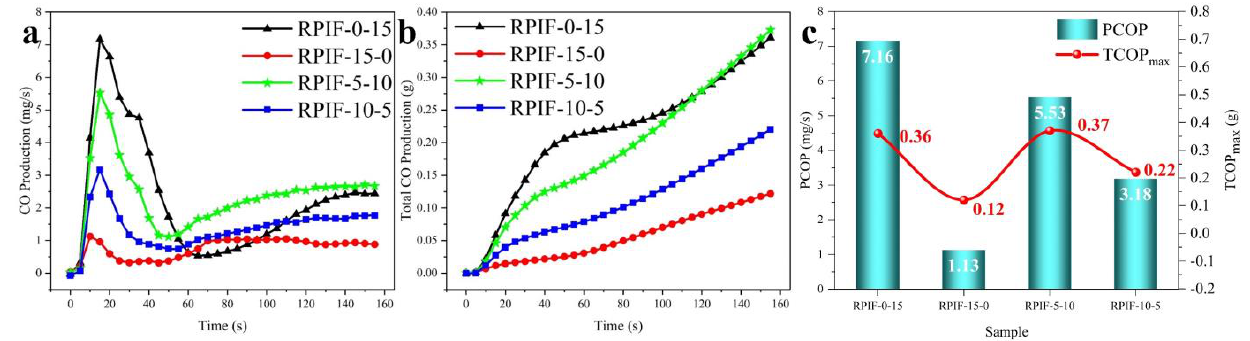
Figure 11. COP ( a ) TCOP ( b ) curves, PCOP and TCOP max ( c ) of RPIF with total dosages of EG and PPCP at 15 wt. %.